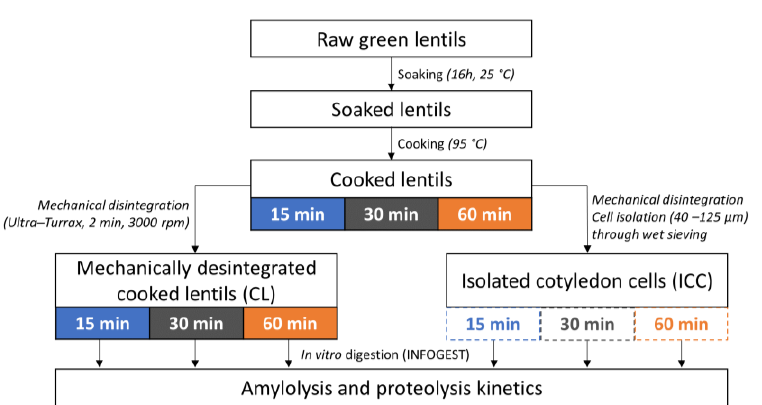
Figure 1. Experimental approach applied to study the effect of cooking time on in vitro starch and protein digestion kinetics in cooked lentil seeds and cotyledon cells isolated thereof.